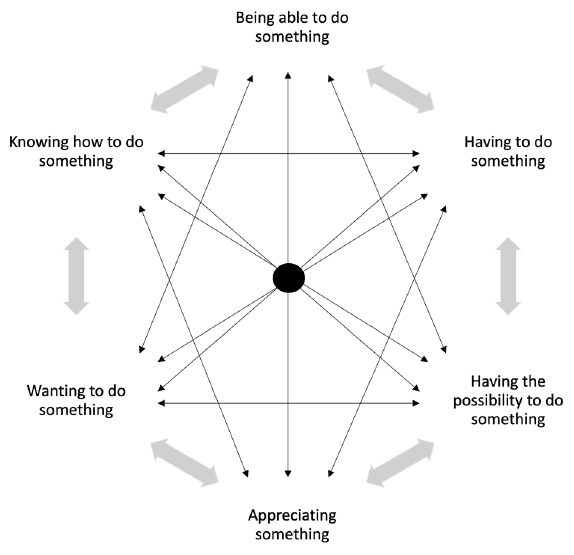
Figure 1. Modalities of Agency Model (Adapted from Jyrkämä 2007 cited in Sallinen et al. 2015).